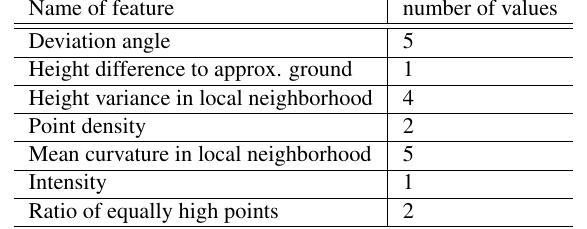
Table 1. The used features for the point-based classification.